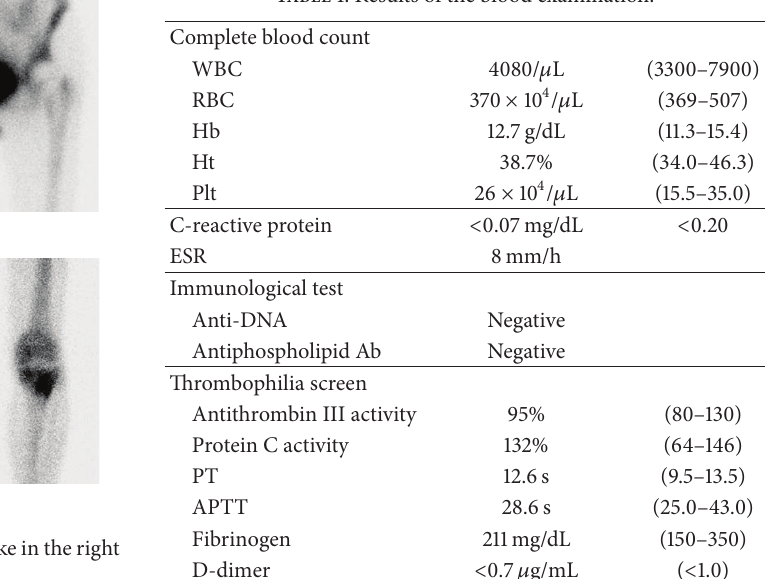
Table 1: Results of the blood